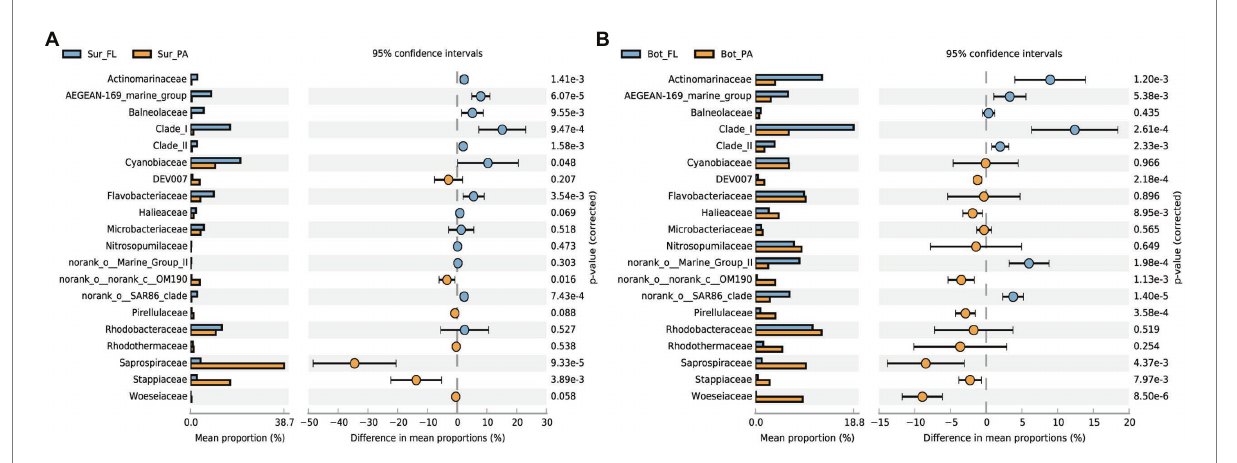
FIGURE 3 Differences in community composition between lifestyles at the family